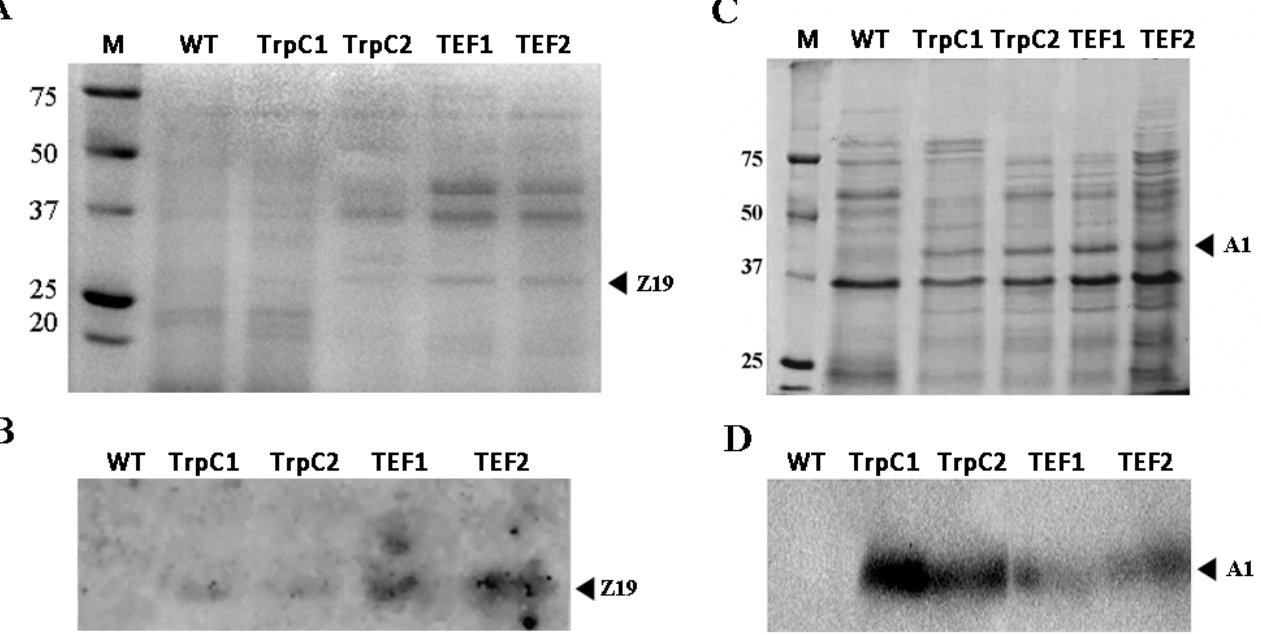
Figure 4. 12.5% SDS-PAGE of ethanol-soluble ( A ) and total water-soluble ( C ) protein fractions isolated from the wild type and Th. thermophilus rF-859 strains. Detection of Z19 ( B ) and A1 proteins ( D ) using Western blotting with anti-6x-His Tag antibodies. Original Western blots are shown in Supplementary Figure S2.